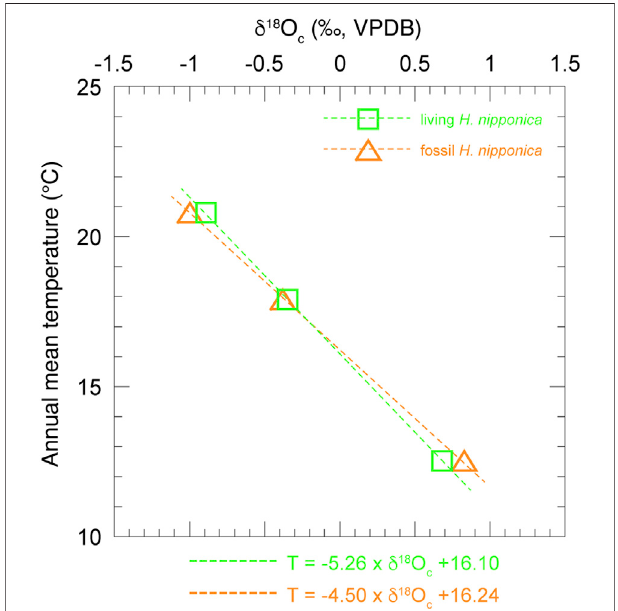
FIGURE 7 | Relationship between δ 18 O c of living and fossil H. nipponica and annual mean bottom water temperature at three sites in Tosa Bay. Green squaresshow data from living H. nipponica and orange triangles indicate data from fossil H. nipponica.